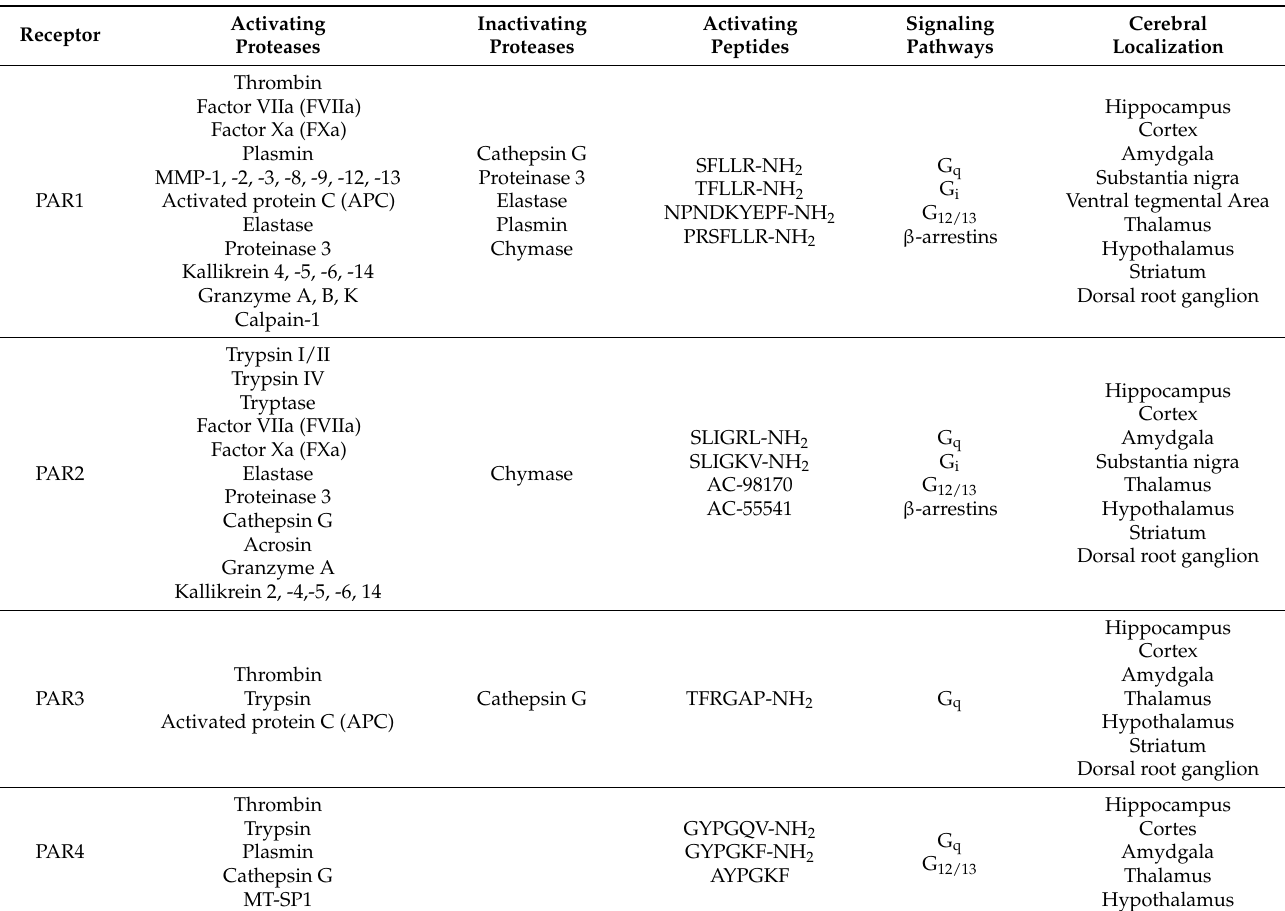
Table 1. Protease-activated receptors (PARs): activation, brain localization, and signaling.